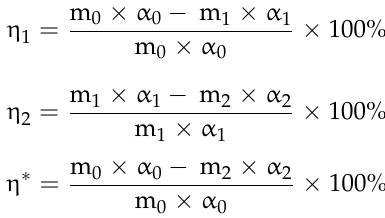
Figure 1. XRD pattern of ferronickel slag.